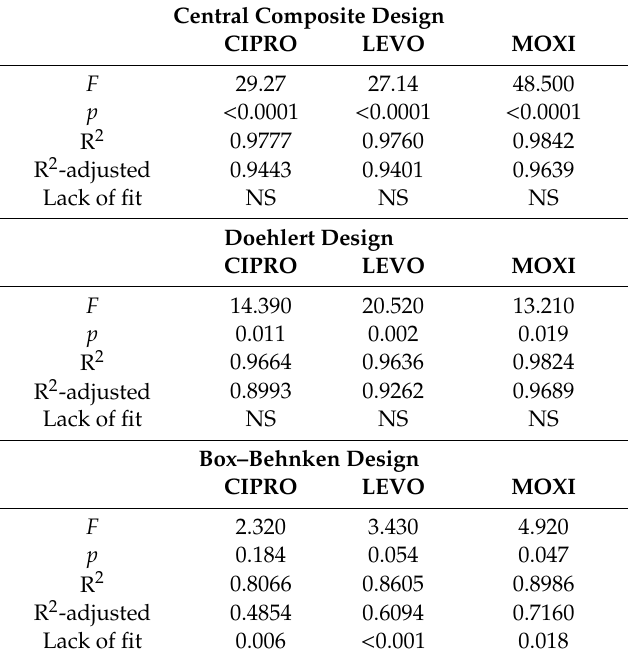
Table 5. The statistical analysis of the applied